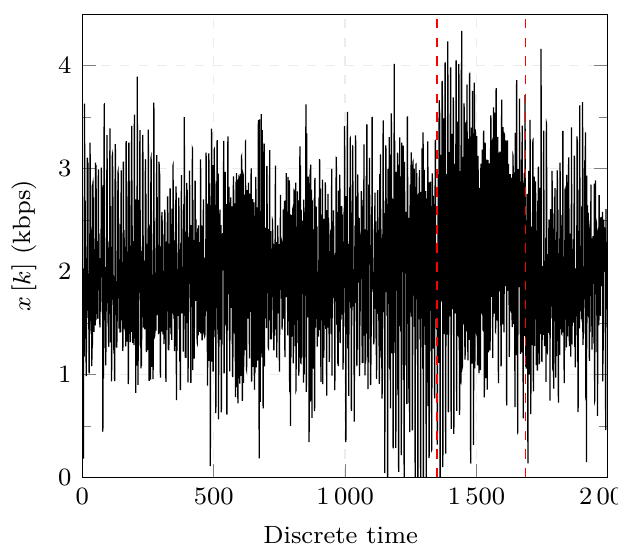
Figure 8. Simulated GOOSE network traffic with a DOS attack.